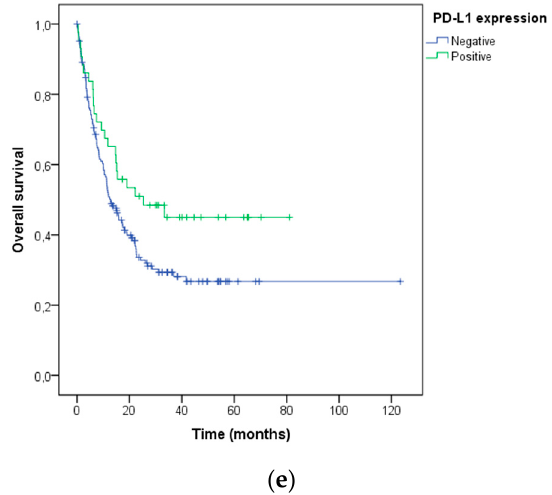
Figure 5. Association of ( a ) systemic ICB treatment line, ( b ) type of ICB, ( c ) histological melanoma subtype, ( d ) BRAF V600 mutation status, and ( e ) PD-L1 expression with overall survival after the ICB treatment in advanced melanoma patients.